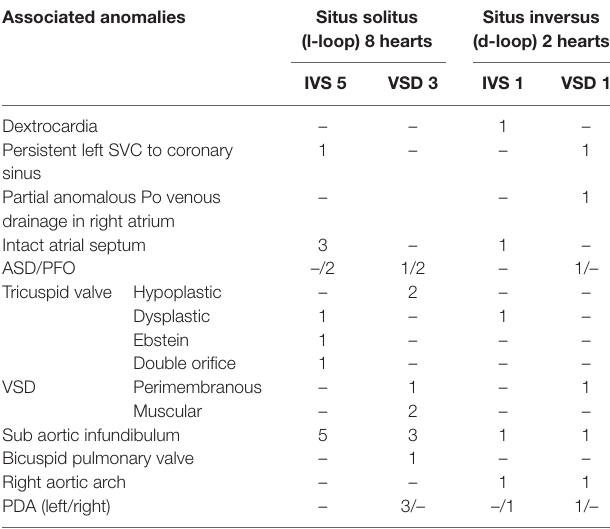
TaBle 9 | corrected Tga: associated anomalies. associated anomalies